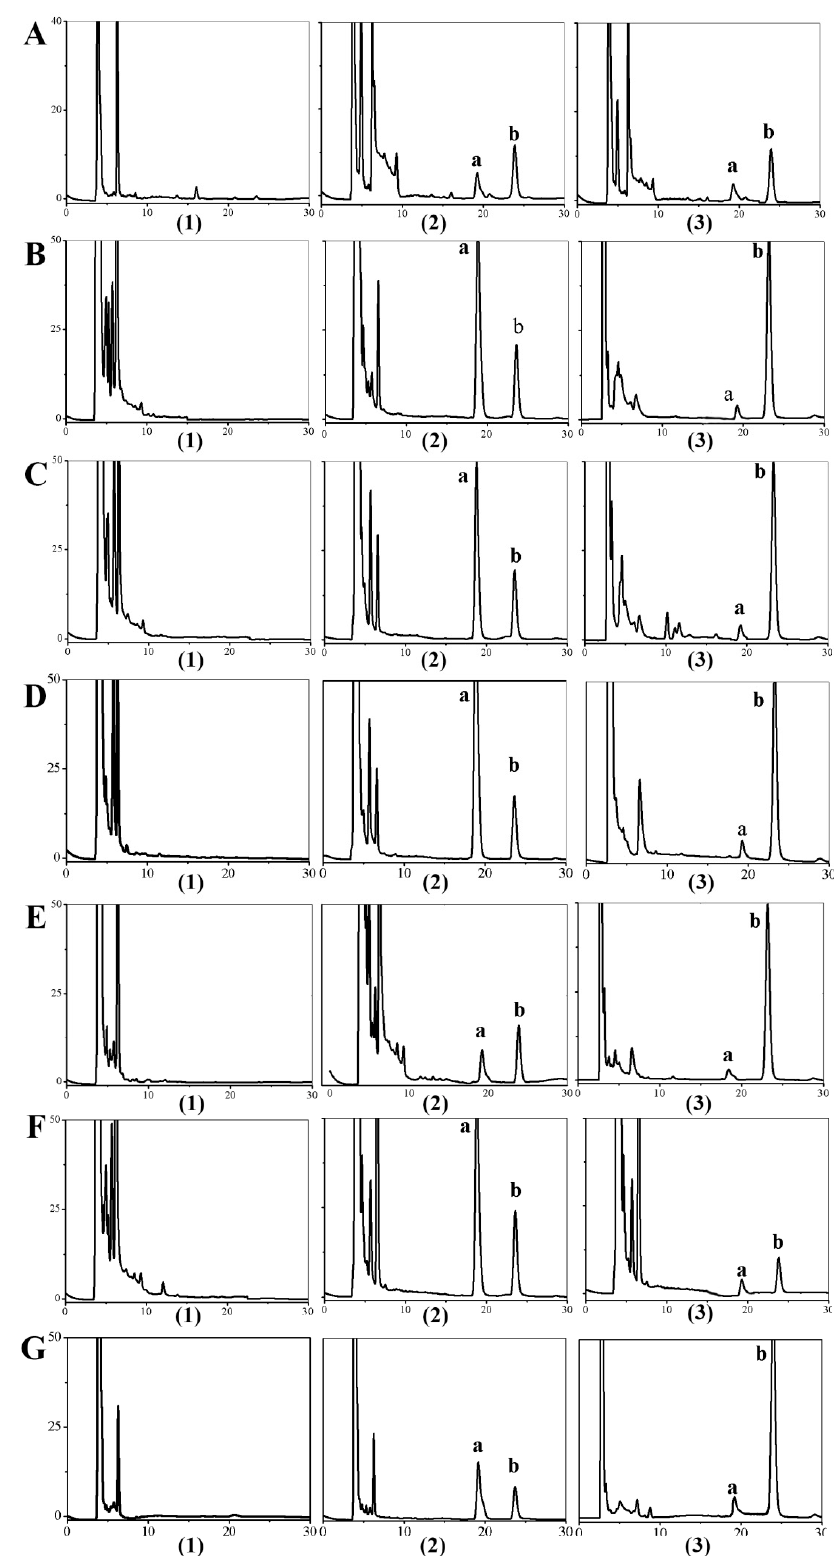
Figure 3. Typical chromatograms obtained from BA in samples: ( A ) Plasma; ( B ) Heart; ( C ) Liver; ( D ) Spleen; ( E ) Lung; ( F ) Kidney; ( G ) Brain; (1) blank samples; (2) samples with addition of standard reference of BA and IS; (3) samples after i.v. administration; (a) the peak of BA; (b) the peak of